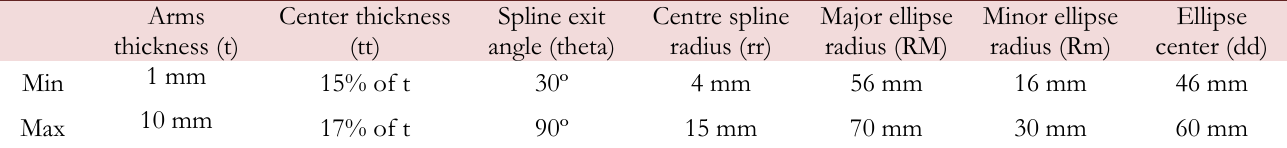
Table 1: Design variables used in the specimen design geometry optimization.